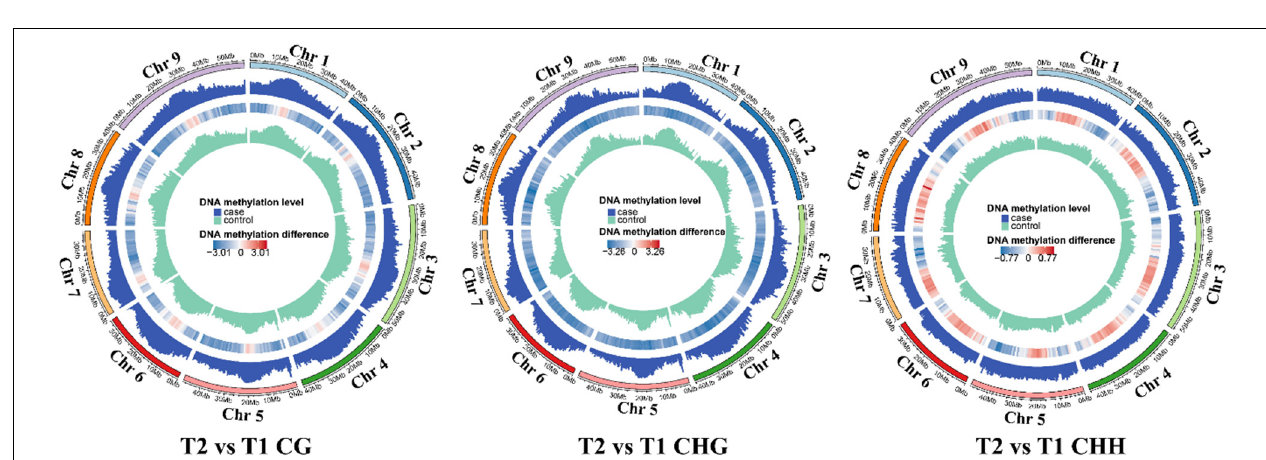
FIGURE 3 | Comparative analysis of DNA methylation levels in different genomic regions.